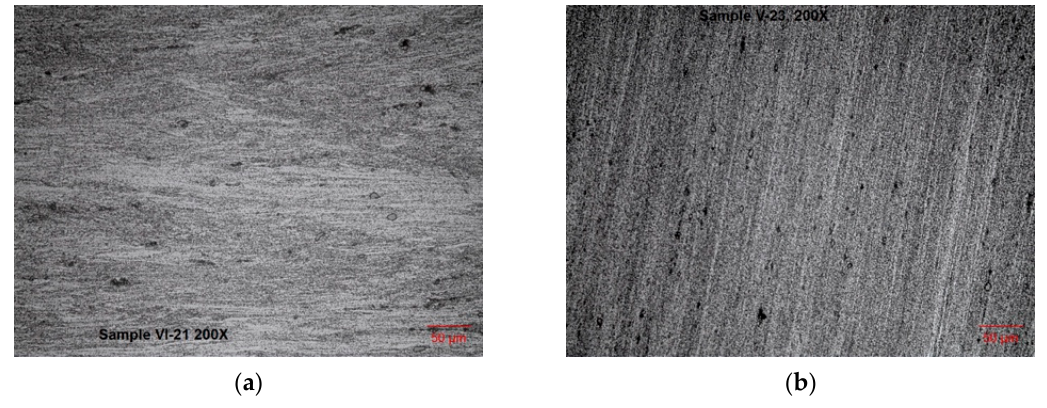
Figure 7. Optical microstructure of the solution-treated AA5083 + four (D) sc-ECAE passes after ( a ) rolling reductions of 50% and ( b ) rolling reductions of 87.5% (scale bars are 50 μ m). Lamellae are oriented in the rolling direction.